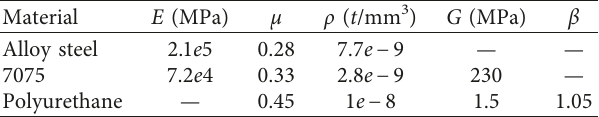
Table 3: Material